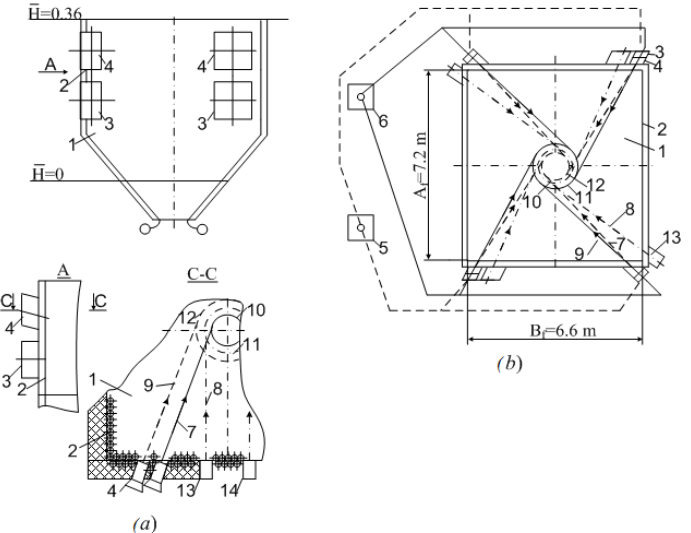
Figure 13. The scheme of the boiler furnace BKZ-160: ( a , b ) longitudinal and transverse sections of the active combustion zone of the furnace with existing dust ducts and multifunctional burners on the side walls; 1—the active combustion zone of the furnace; 2—screens; 3, 4—burners of the lower and upper tiers; 5, 6—mills; 7, 8, 9—flows of dust–air mixture, natural gas, air; 10, 11, 12—conditional contact circles of reagents 7, 8, 9; 13—gas nozzles; 14—fuel oil nozzles; H = H/H T , where H and H T —current and full height of the furnace,